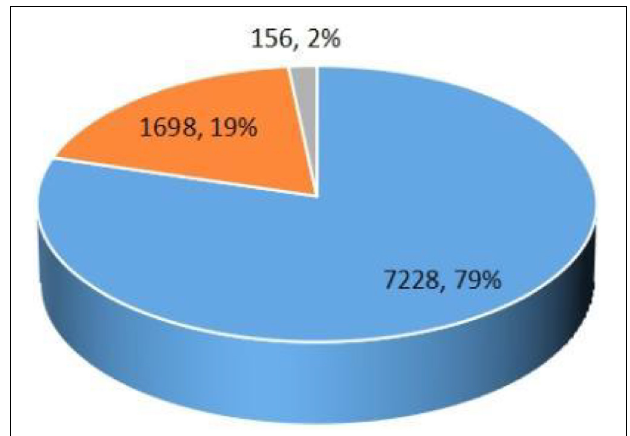
FIGURE 1 | Distribution of procurement model